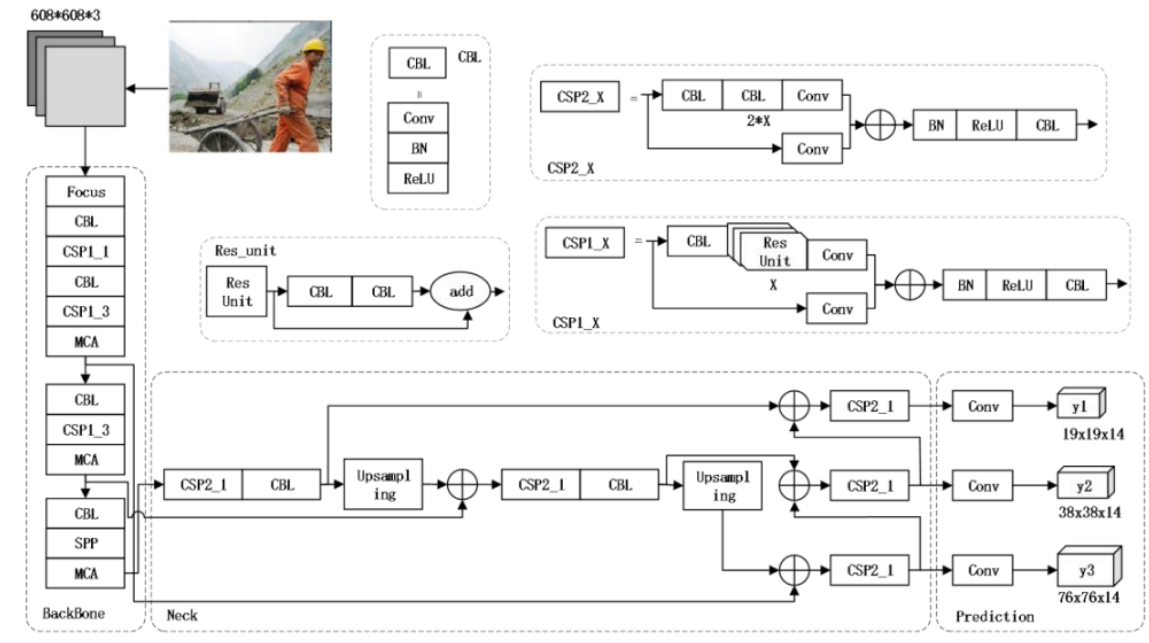
Figure 2. The MCA-YOLOv5 network model structure.